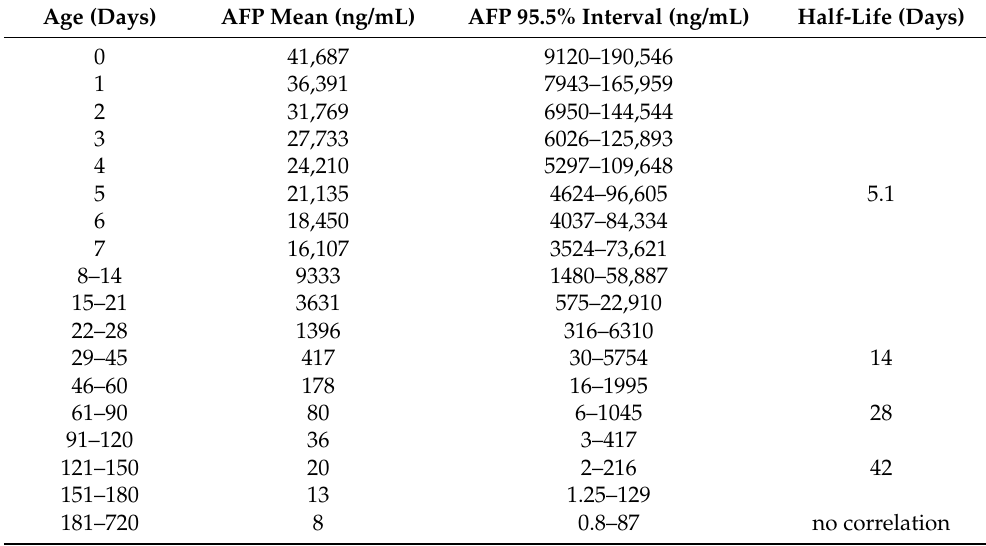
Table 1. Serum AFP value of term babies according to Blohm et al., (1998), Pediatr. Hematol. Oncol